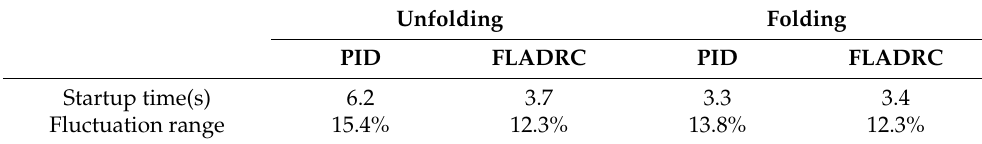
Table 6. Assessment indices of cylinder #6 motion control using PID and FLADRC.